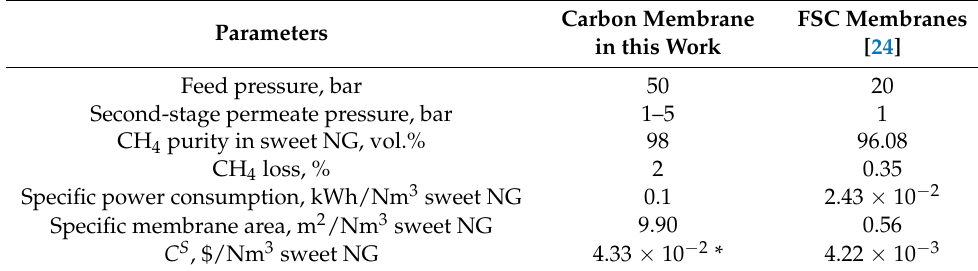
Figure 4. The influence of the second-stage permeate pressure on the NG processing cost. Table 4. Comparisons between carbon membranes and fixed-site-carrier (FSC) membranes for CO 2 removal from natural gas.